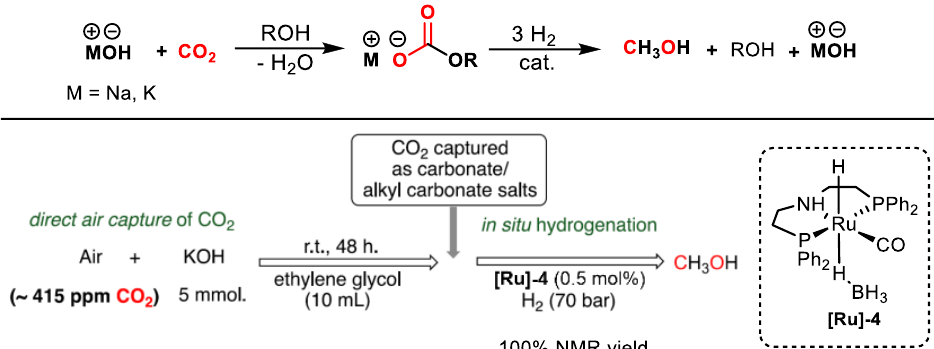
Figure 8. Inorganic base aided Ru-catalyzed hydrogenation of CO 2 .